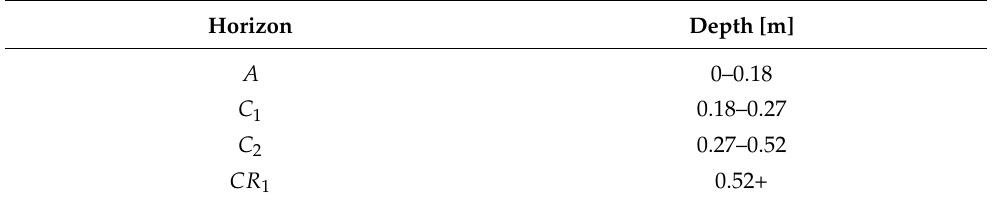
Table 7. Pedogenetic horizons of Leptosol.